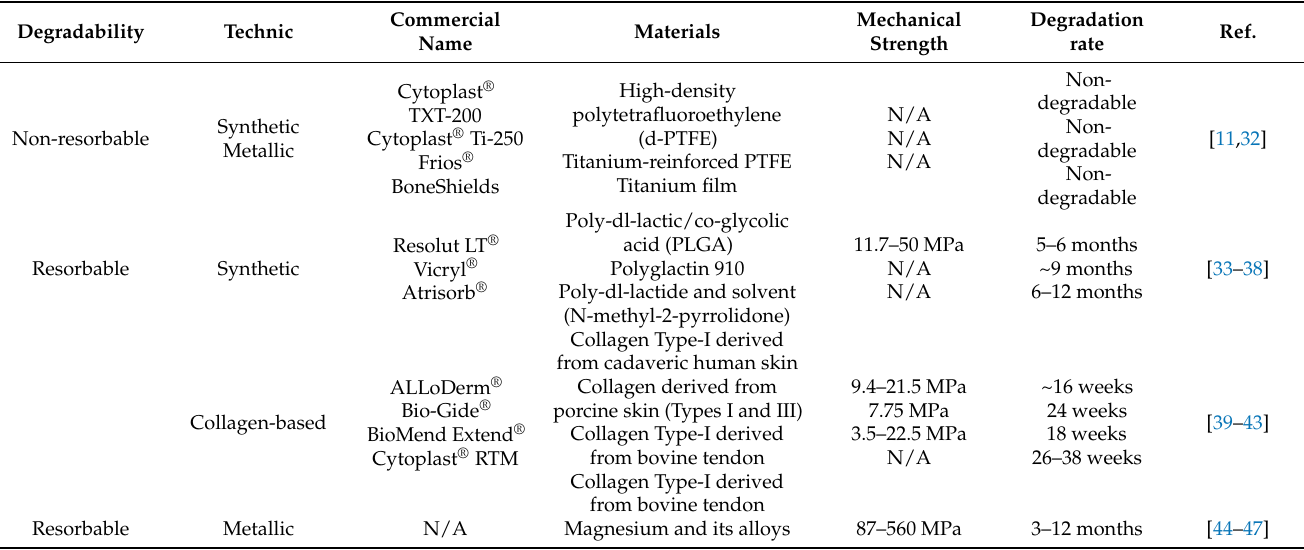
Table 1. Comparison between the present commercial membranes and Mg-based